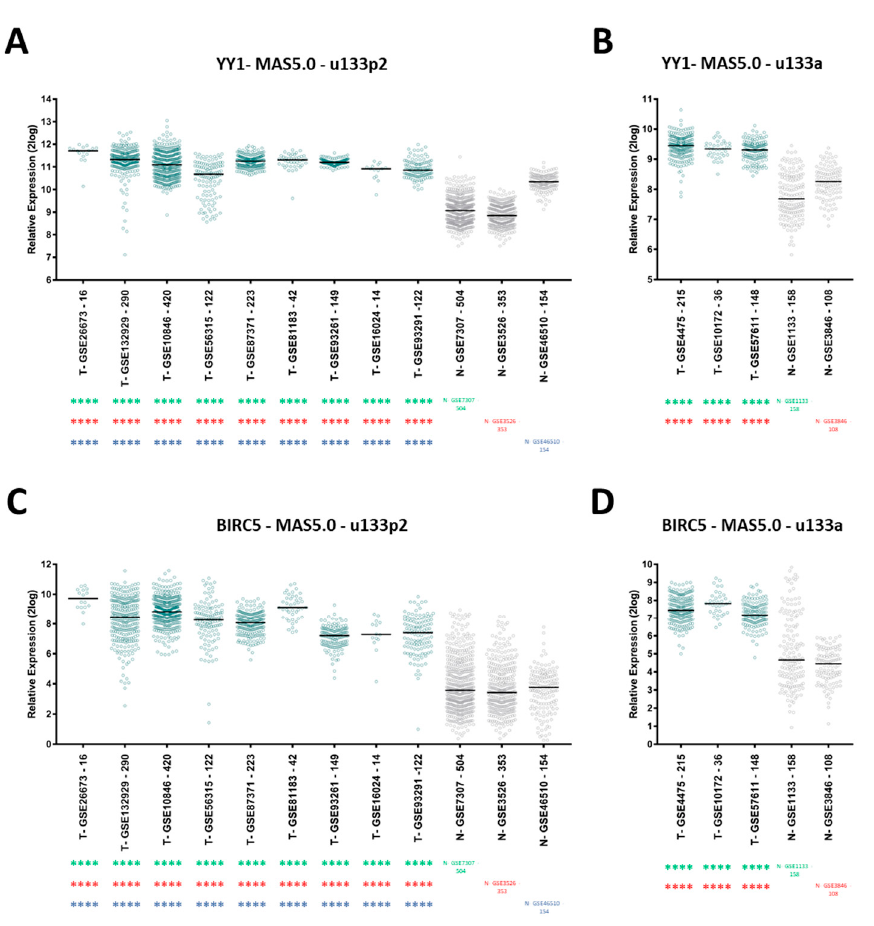
Figure 2. R2 analysis of YY1 and BIRC5 expression levels in B-NHL patients vs. healthy controls. Comparisons have been performed between datasets generated with same array and same normalization method (MAS5.0). ( A ). YY1 relative expression levels are significantly higher in nine di ff erent B-NHL patients GEO datasets (T, tumor) compared to each of three di ff erent normal samples GEO datasets (N, Normal; u133p2 array); ( B ). YY1 relative expression levels are significantly higher in three di ff erent B-NHL patients GEO datasets (T) compared to each of two di ff erent normal samples GEO datasets (N; u133a array); ( C ). BIRC5 relative expression levels are significantly higher in nine di ff erent B-NHL patients GEO datasets (T) compared to each of three di ff erent normal samples GEO datasets (N; u133p2 array); ( D ). BIRC5 relative expression levels are significantly higher in three di ff erent B-NHL patients GEO datasets (T) compared to each of two di ff erent normal samples GEO datasets (N; u133a array). The relative gene expression levels are expressed as log2 (base 2 logarithmic values). The number of samples per each dataset is indicated along with the GSE dataset ID. The results are presented as Median ± SD. One-way ANOVA with Tukey’s post-hoc test analysis has been performed (**** p <